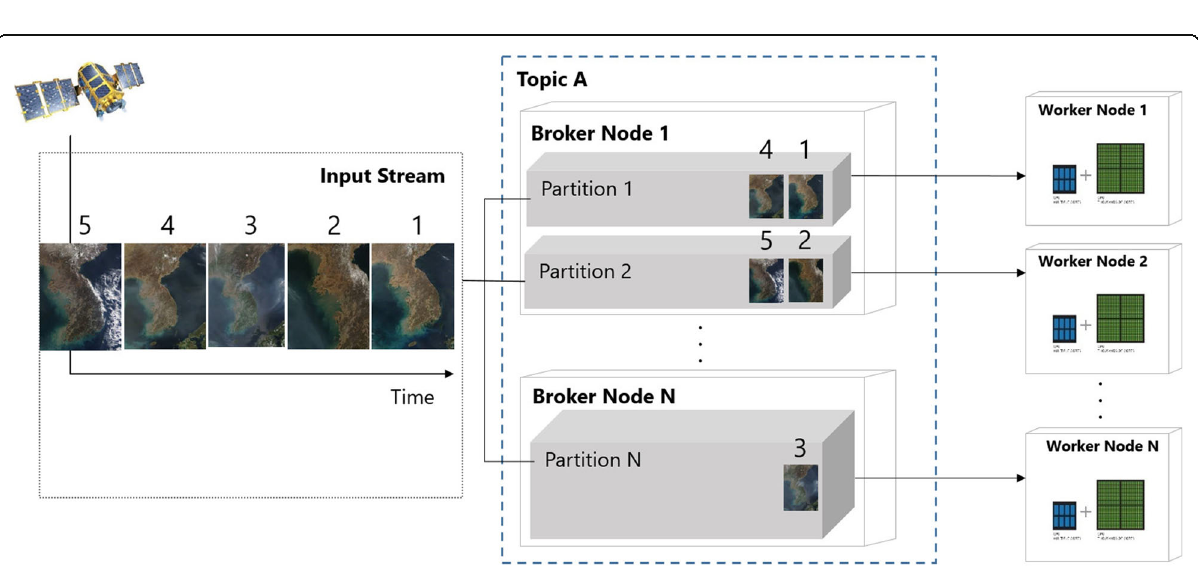
Fig. 2 Partitioning of input stream for multiple nodes